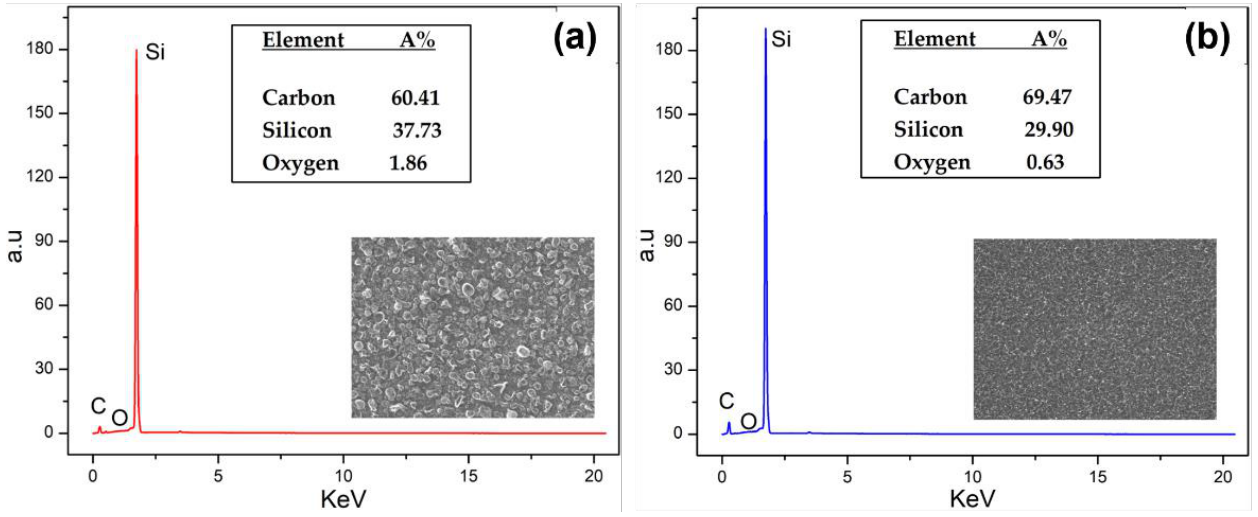
Figure 6. EDS spectrum of graphene on SiC in few layers ( a ) and multilayer ( b ) samples, respectively.